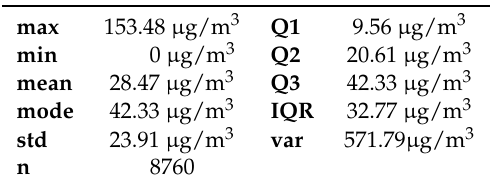
Table 1. Summary descriptive statistics of hourly NO 2 concentrations from Blanchardstown air quality monitoring station in Dublin, Ireland. The statistical quartiles (Q1, Q2, Q3) and the interquartile range (IQR) are also displayed. Take into account that 0 µ g/m 3 represents a missing or wrong